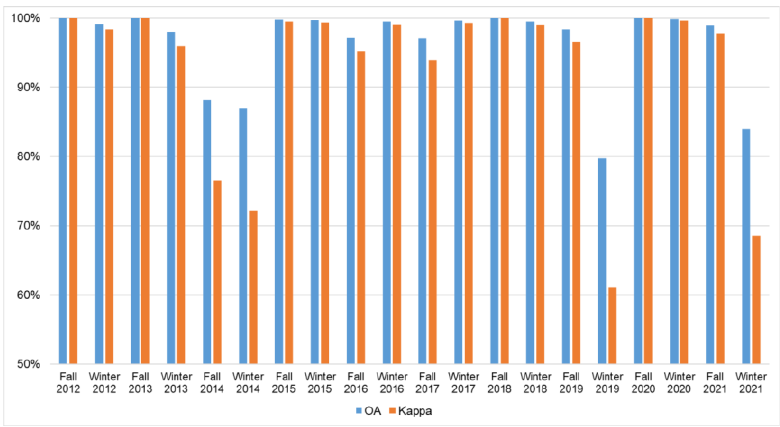
Figure 10. Snow/ice cover classification accuracies using RF algorithm from 2012 to 2022.